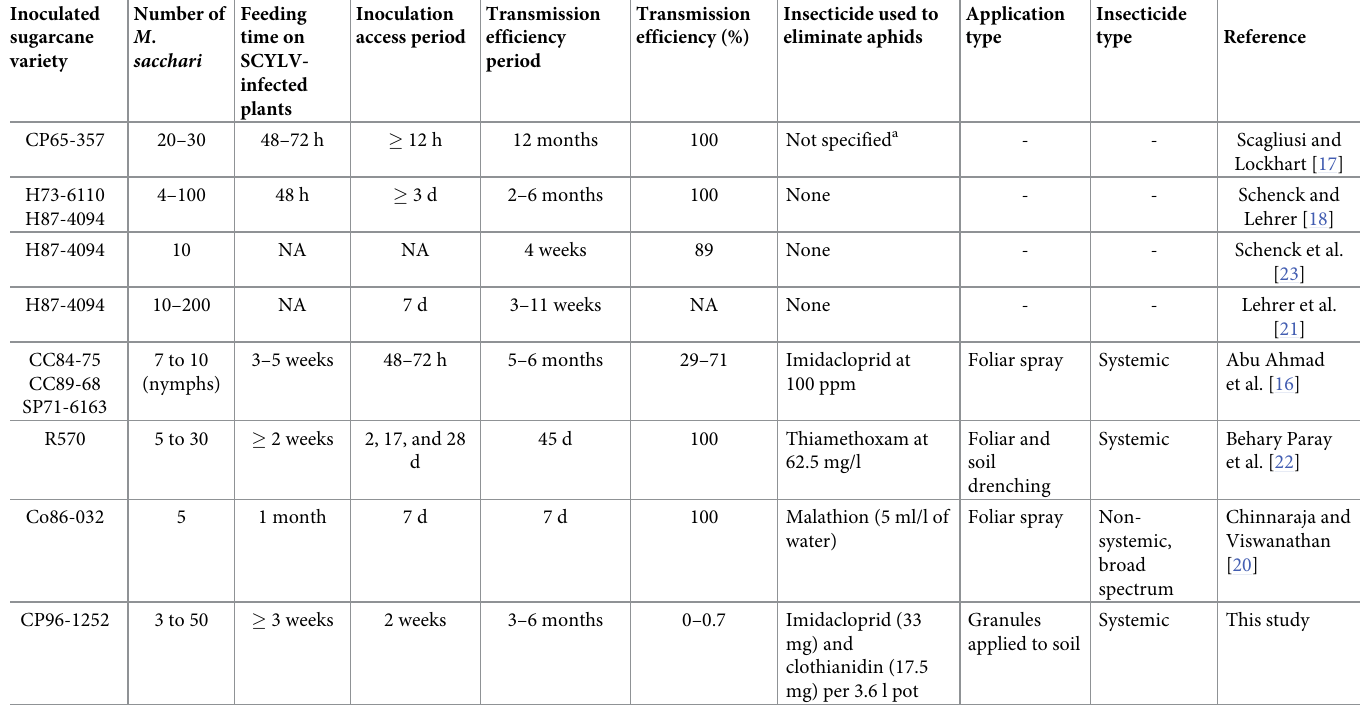
Table 3. Characteristics of published transmission experiments from sugarcane ( Saccharum spp.) infected by sugarcane yellow leaf virus (SCYLV) to healthy sugar- cane with the aphid Melanaphis sacchari